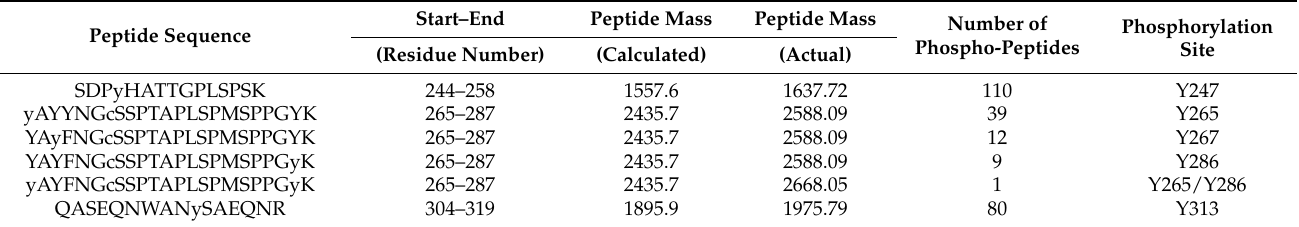
Table 1. Phospho-Tyr containing peptides identified from the mass spectroscopy of the Cx43CT in vitro phosphorylated by BTK.